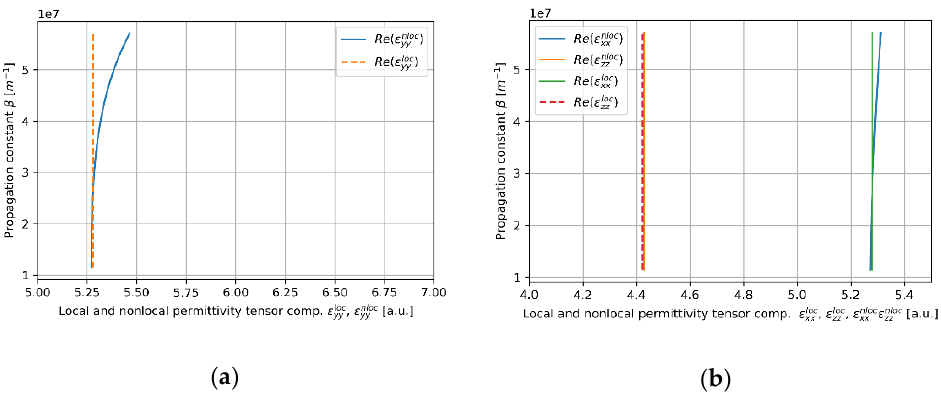
Figure 5. Real parts of components of effective local and nonlocal tensors (horizontal axis) of the core layer with dielectric layer thickness t Nb2O5 = 5 nm plotted versus propagation constant (vertical axis), which are encountered by TE ( a ) and TM waveguide modes ( b ).